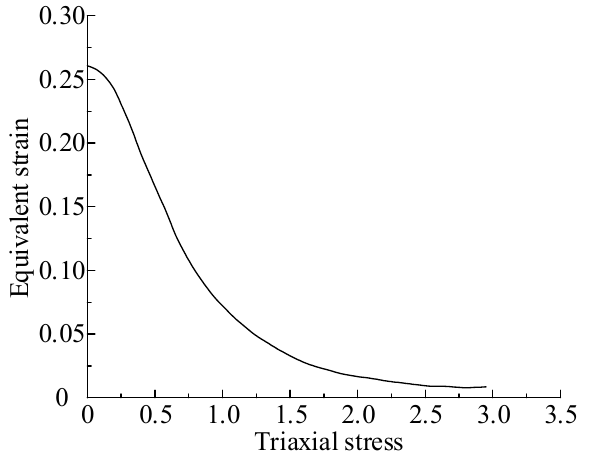
Figure 8. Plastic damage model of the studs.